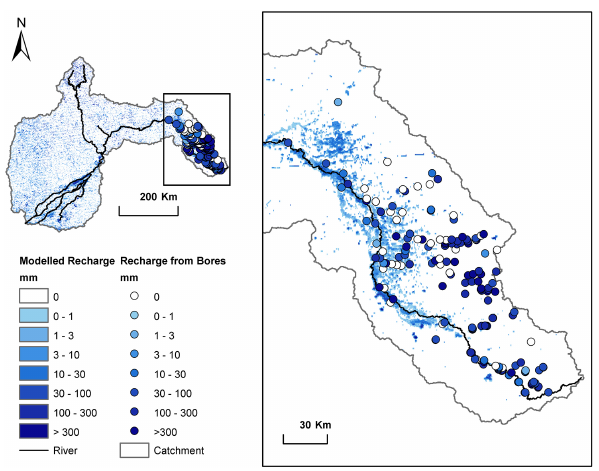
Fig. 8. Modelled OFR and total recharge calculated from bore re- sponses for the Condamine